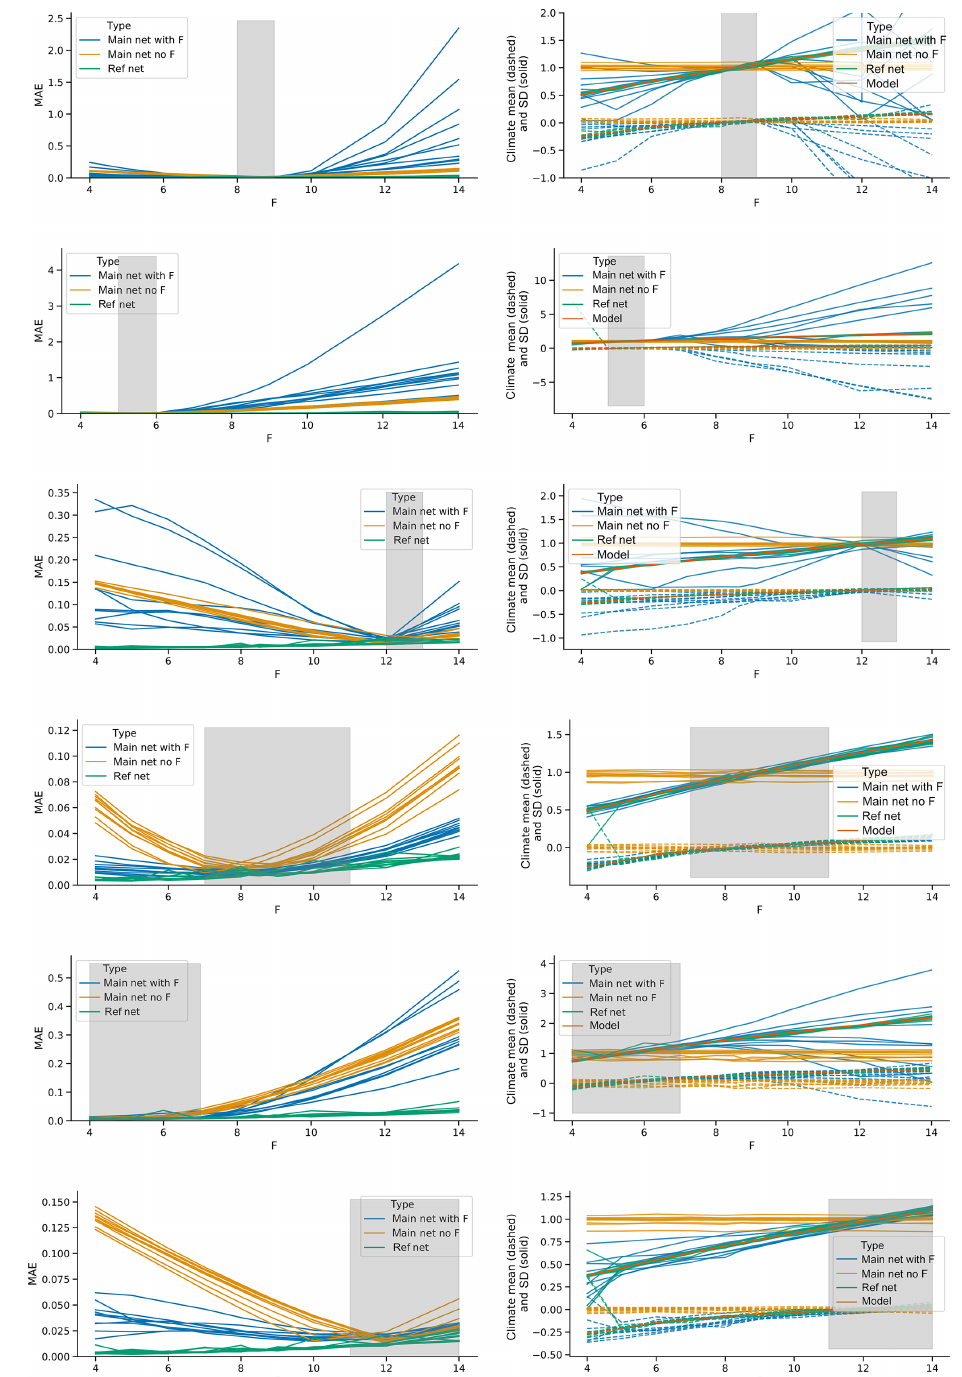
Figure 8. Short-term forecast errors and network attractor reconstructions for forcing experiments with Lorenz95. Networks are trained on a run with linearly increasing F from the lower to upper ends of the grey shaded area in the plots and then tested on runs with fixed F . The blue lines show the network that includes F as input. The yellow lines show the networks without F as input (“no input” networks in the text). The green lines show reference networks without F as input that are trained on runs with F fixed to the same value as the test runs (“no F ” networks in the text). The left panels show short-term forecast error, the right panels the mean and standard deviation of climate runs performed with the networks and additionally the mean and standard deviation of Lorenz95 runs with F fixed to the reference values (orange